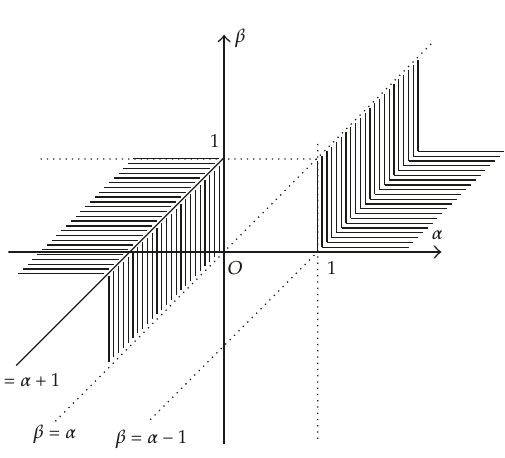
Figure 1: (cid:3) α,β (cid:5) -domain where q α,β (cid:3) t (cid:5) increases on (cid:3) −∞ , ∞ (cid:5) .